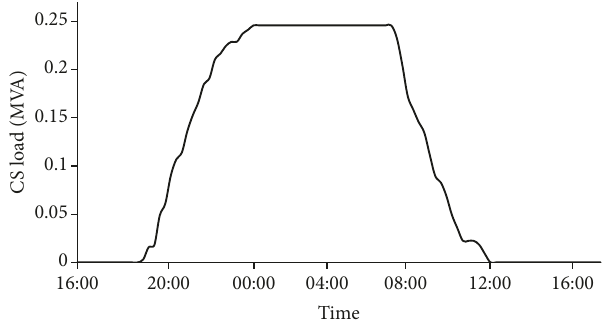
Figure 4: Load produced by CS over time.